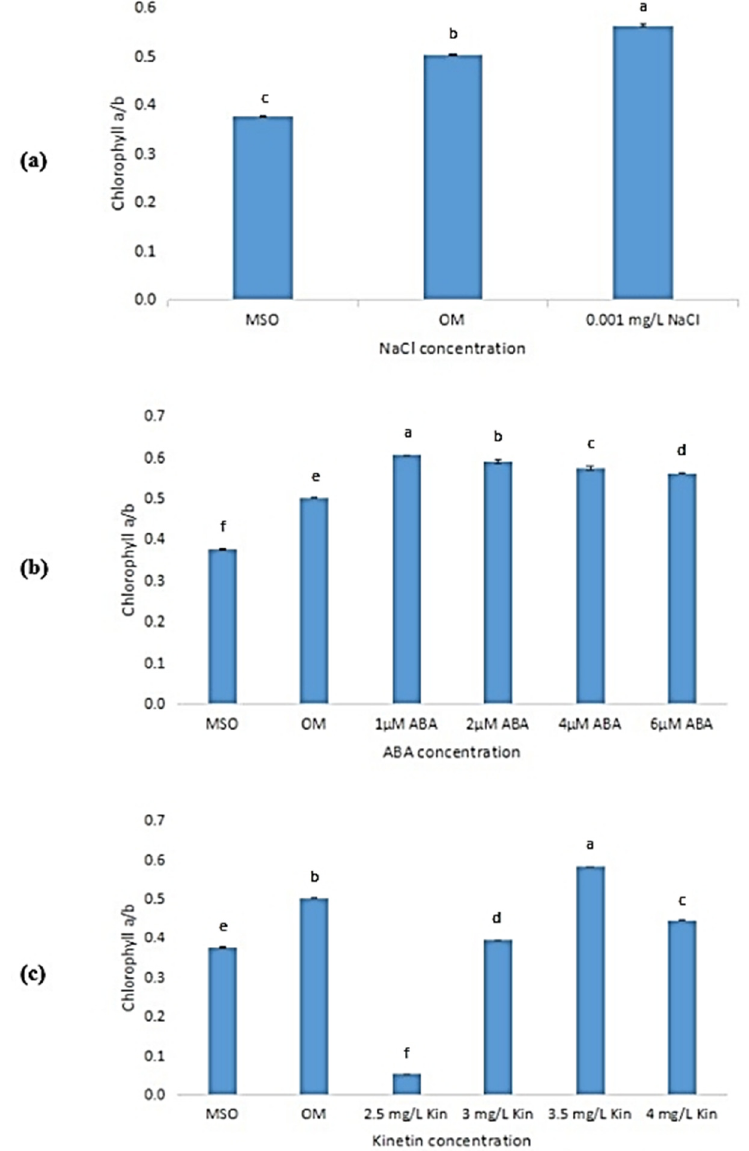
Figure 7. Ratio of chlorophyll a to chlorophyll b in plants exposed to: ( a ) salt stress (0.001 mg/L NaCl); ( b ) ABA; ( c ) high kinetin levels. Means with different letters are significantly different at p < 0.05 according to Duncan’s multiple range test (DMRT).